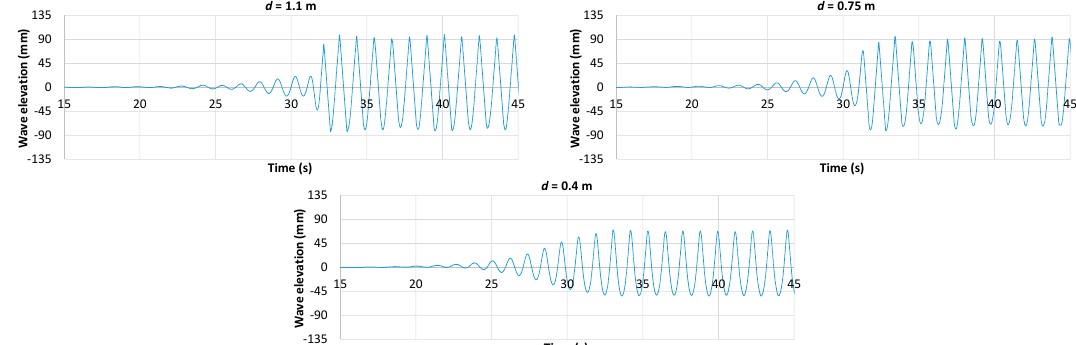
Figure 4. Measured wave elevation on three water depths with T = 1.15 s and A = 50.5 mm.